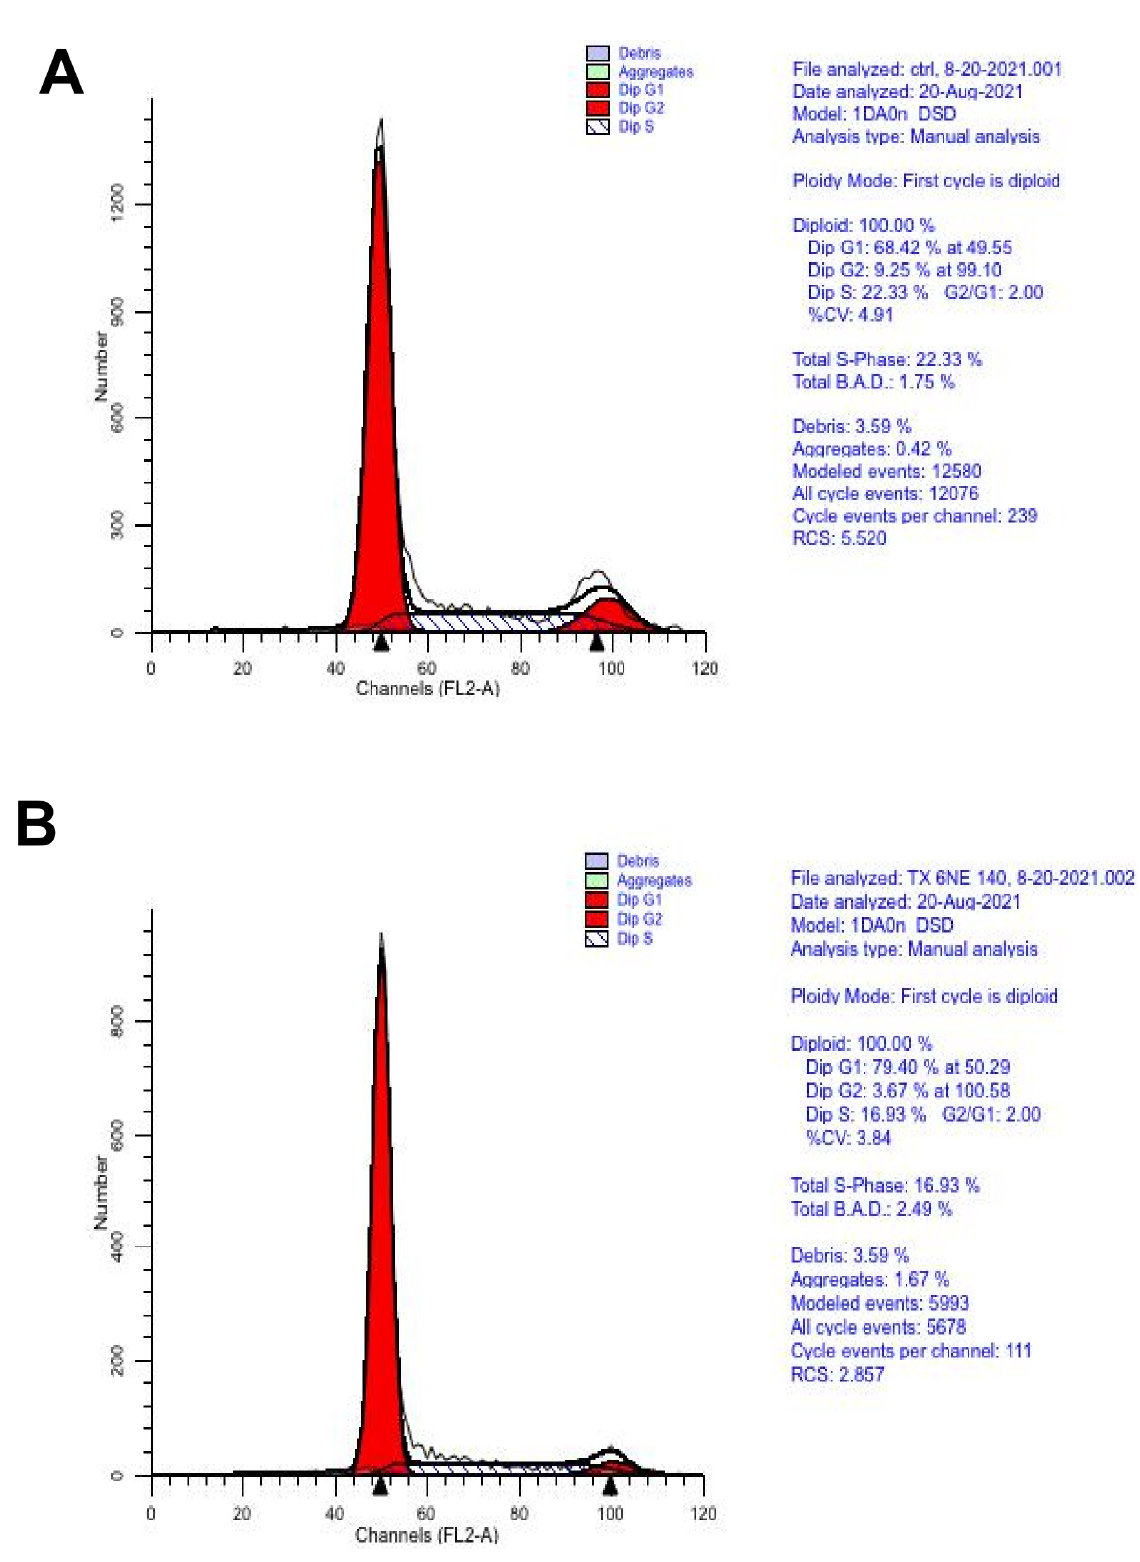
Figure 11. The effects of GNE-140 (50 μ M) on cell cycle progression in MDA-MB-231 cells as determined by flow cytometry ( A ) Control vs. GNE-140 treatment ( B ). Abbreviations: 1D0n DSD is the name of the program run for the sample under auto-analysis of the software; total B.A.D—background aggregates and debris (<20% is good); RCS—reduced chi-square; DIP—diploid; %CV—coefficient of variance, <8 is acceptable.